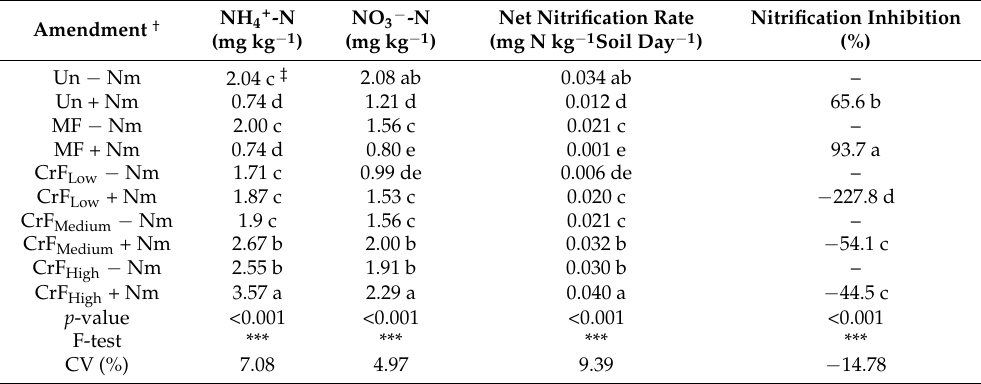
Table 2. Soil mineral nitrogen (NH 4+ -N and NO 3 − -N), net nitrification rate, and nitrification inhibi- tion as affected by the combined uses of different rates of cricket frass and neem seed